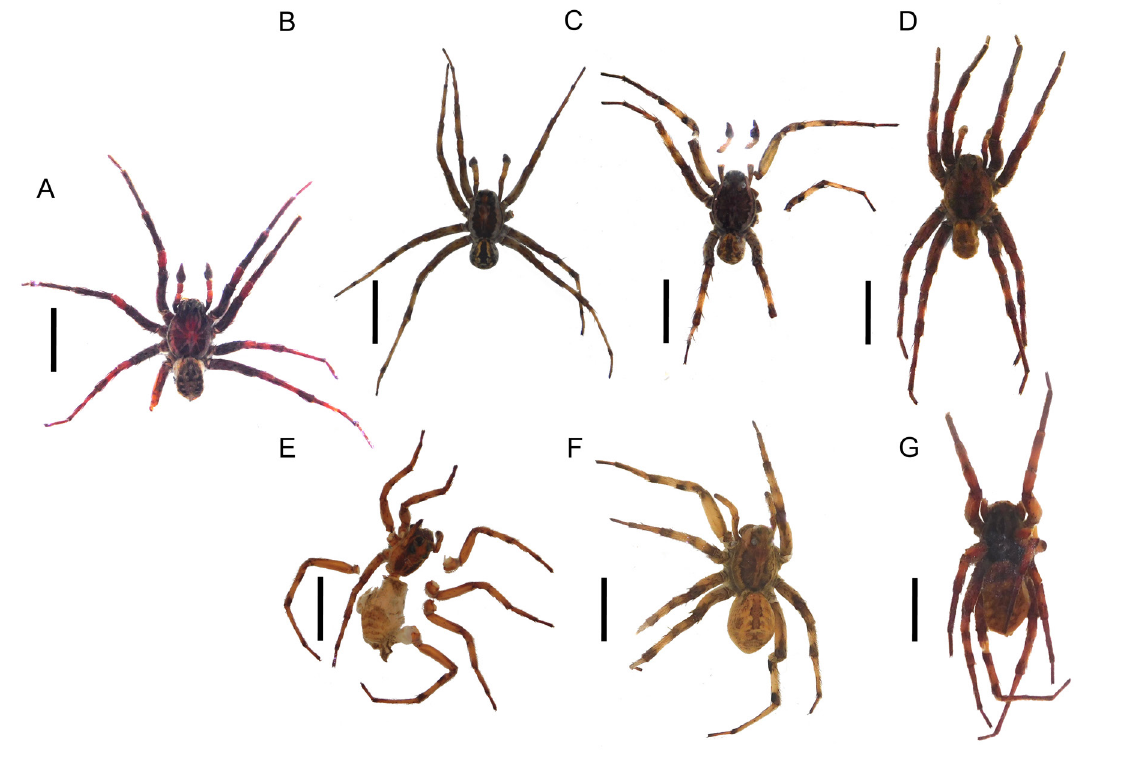
Fig. 6. Habitus, dorsal view. A . Geolycosa vultuosa C.L. Koch, 1838, ♂ (HUJ INV-AR20961). B . Lycosa gesserit sp. nov . , holotype, ♂ (HUJ INV-AR20631). C . Lycosa hyraculus sp. nov . , holotype, ♂ (HUJ INV-AR20818) . D . Lycosa piochardi Simon, 1876, ♂ (HUJ INV-AR20597). E . Lycosa sp . , ♀ (HUJ INV-AR20573). F . Lycosa hyraculus sp. nov . , paratype, ♀ (HUJ INV-AR20817). G . Lycosa piochardi Simon, 1876, ♀ (SMFD11934). Scale bars = 10 mm. Photos by I. Armiach